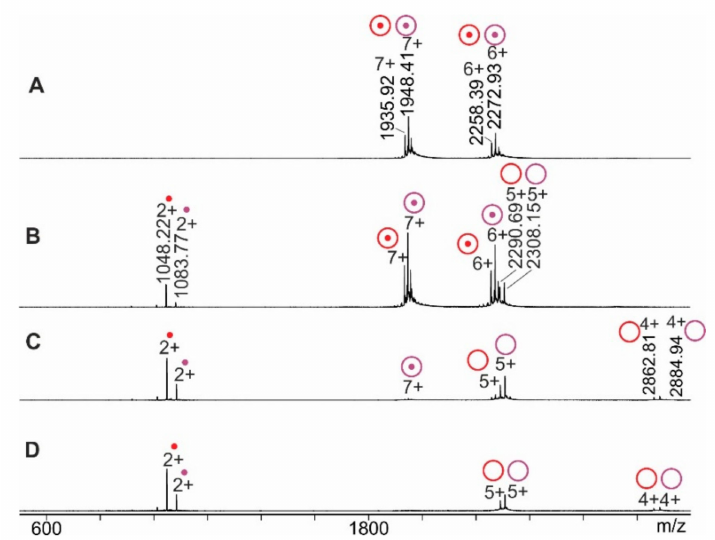
Figure 3. Nano-ESI mass spectra of RNAse S dissociation reactions. Collision cell voltage differences ( ∆ CV ): ( A ): 3 V. ( B ): 11 V. ( C ): 30 V. ( D ): 50 V. Charge states and m / z values for selected ion signals are given. RNAse S ions (reddish circles with dots), S-protein ions (reddish circles without dots), and released S-peptide ions (reddish dots) each represent the two major molecular species (red: low molecular weight species; purple: high molecular weight species). Solvent: 200 mM ammonium acetate/methanol (90:10, v / v ), pH